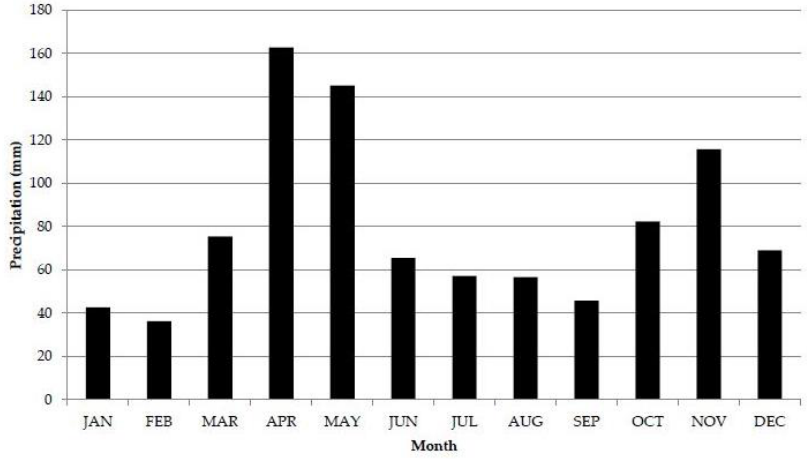
Figure 5. Observed precipitation data (KMD) in Kenya from 1970 – 2000.